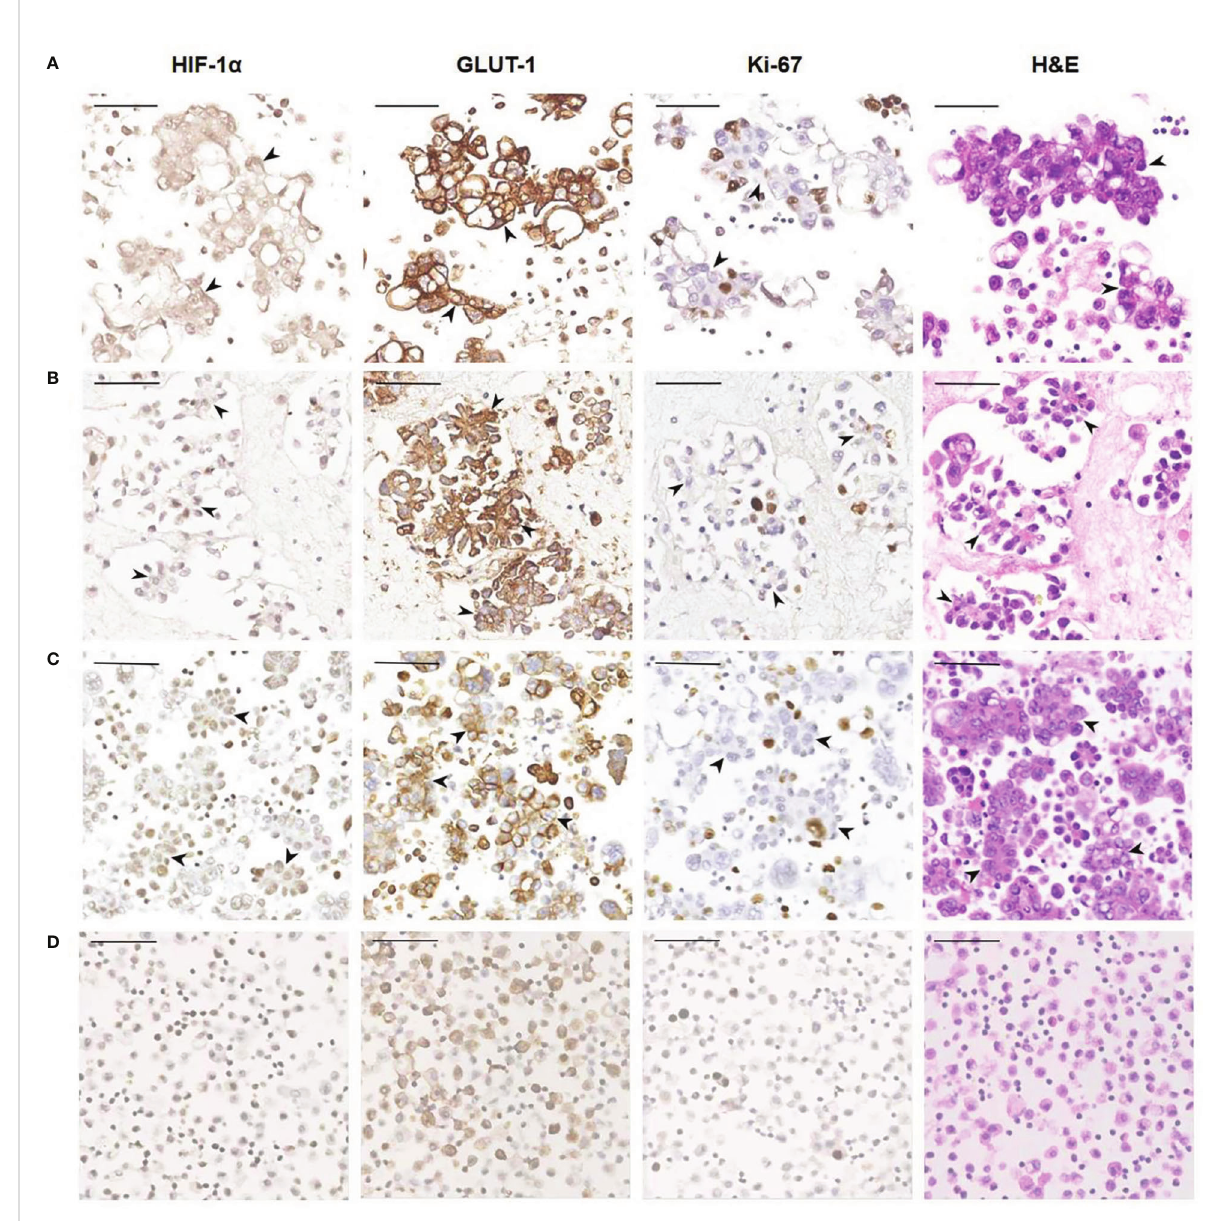
FIGURE 3 Representative images showing HIF-1 a , GLUT-1 and Ki-67 expression of human ovarian cancer cells in ascites. (A) A 56-year-old female diagnosed with high-grade serous carcinoma of the ovary. The black arrowheads show clusters of tumor cells in ascites (400×). These tumor cells are HIF-1 a positive and GLUT-1 positive with a relatively low Ki-67 index. Bar , 50 m m. (B) A 61-year-old female was diagnosed with high-grade serous carcinoma of the ovary. The black arrowheads show the papillary arrangement of tumor cells in ascites (400×). These tumor cells are HIF-1 a positive and GLUT-1 positive with a relatively low Ki-67 index. Bar , 50 m m. (C) A 57-year-old woman diagnosed with high-grade serous carcinoma of the ovary. The black arrowheads show the papillary arrangement of tumor cells in ascites (400×). These tumor cells are HIF-1 a positive, GLUT-1 positive with a relatively low Ki-67 index. Bar , 50 m m. (D) Non-neoplastic benign effusion. There are in fl ammatory cells mainly composed of lymphocytes and reactive mesothelial cells. Some of these cells also express HIF-1 a and GLUT-1, and the Ki-67 index is low. Bar , 50 m